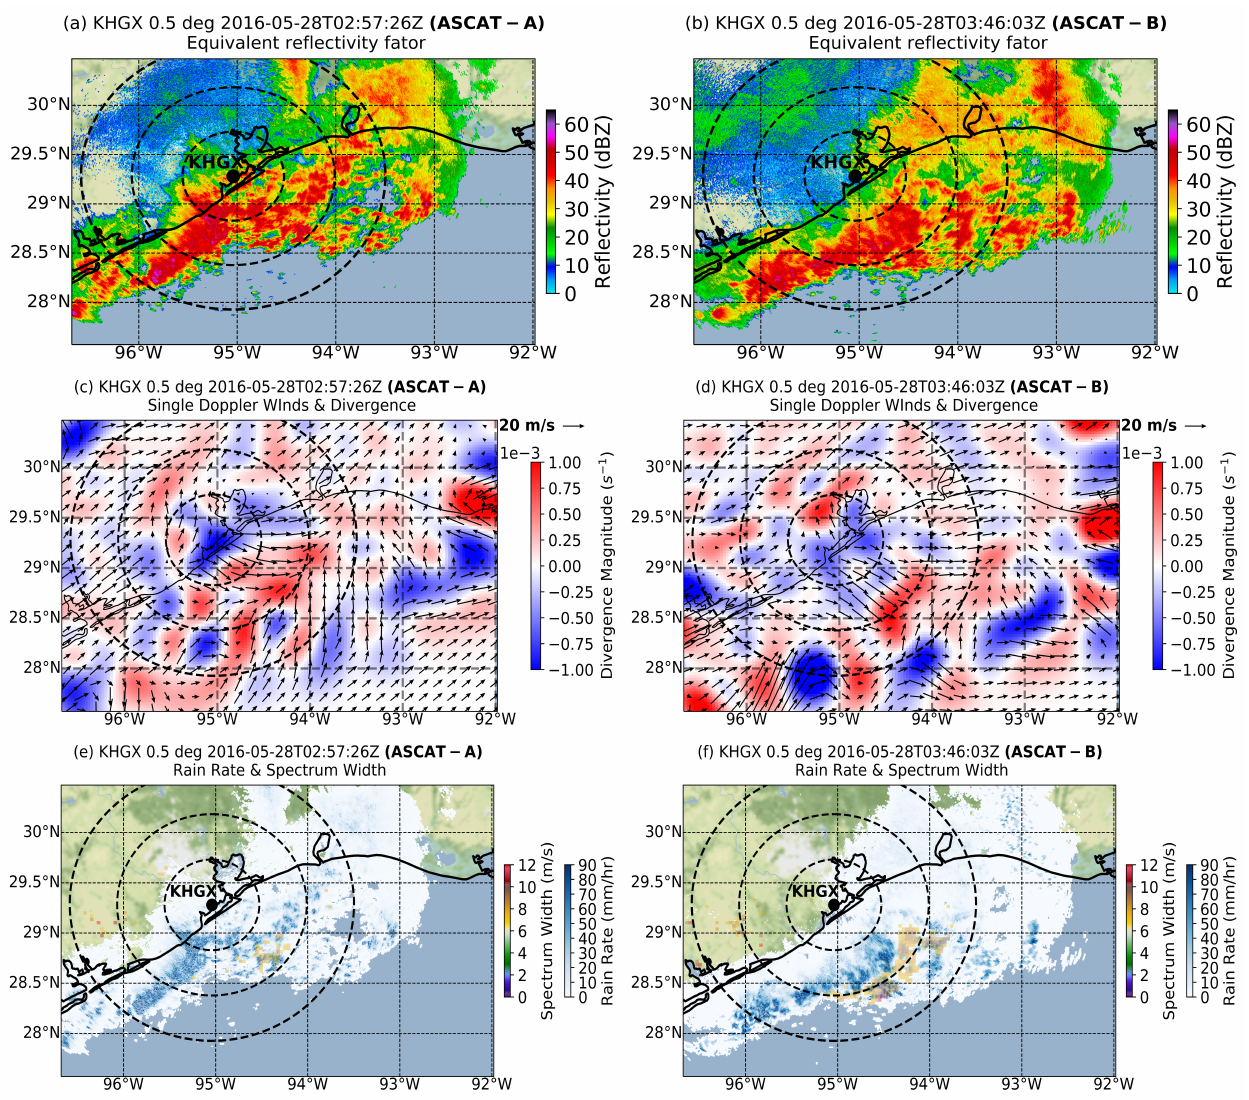
Figure 2. NEXRAD (KHGX) and single-Doppler analysis wind fields. The subfigures at the left correspond to the closest time of ASCAT-A overpass: ( a ) Radar reflectivity field (in dBZ), ( c ) single-Doppler analysis wind field (in m s − 1 ) and divergence field (in s − 1 ), and ( e ) radar-estimated precipitation rate (in mm h − 1 ) with enhanced spectrum width magnitude (in m s − 1 ). ( b , d , f ) have the same configuration but correspond to the closest time of ASCAT-B overpass. Dashed concentric circles indicate radial distance from the radar at 50, 100 and 150